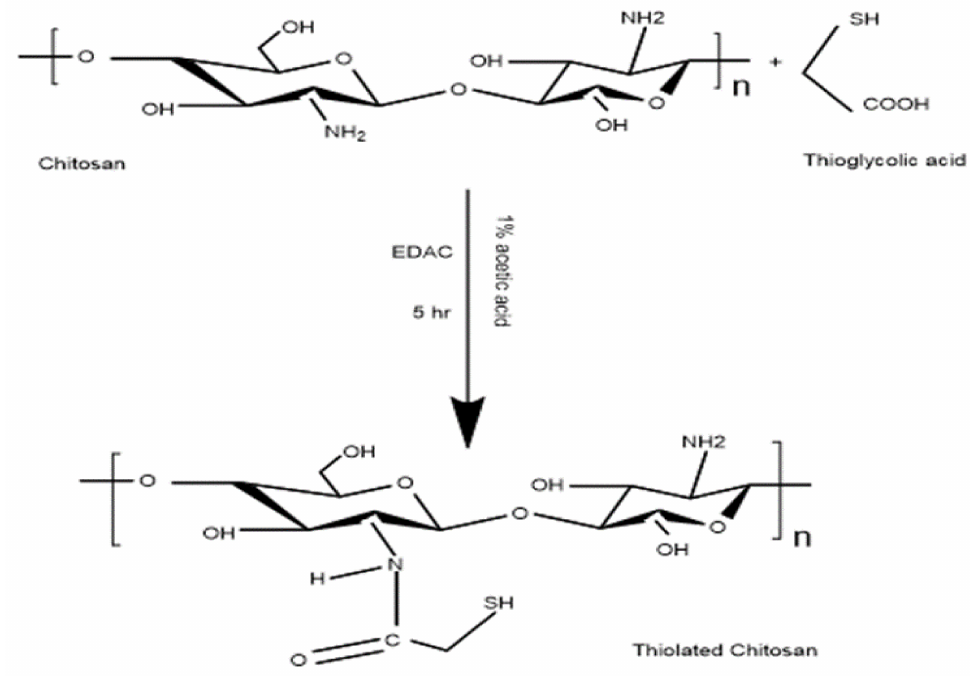
Figure 1. Reaction scheme for thiolation of chitosan by formation of covalent bond between thiogly- colic acid and chitosan via EDAC